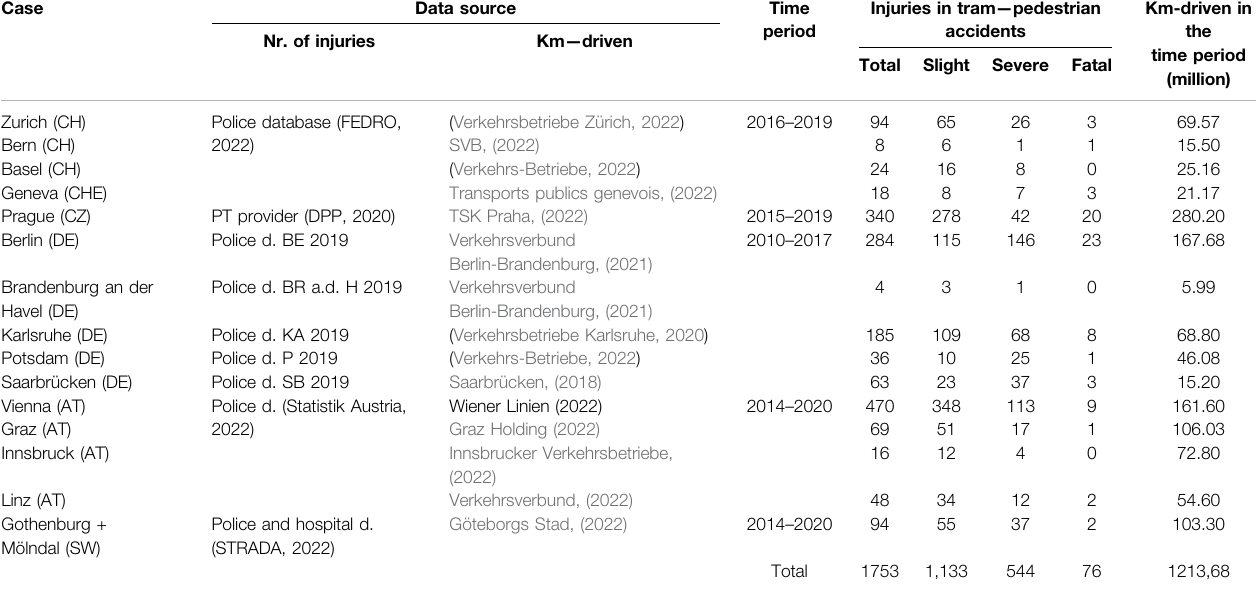
TABLE 1 | Data for tram-pedestrian accident risk